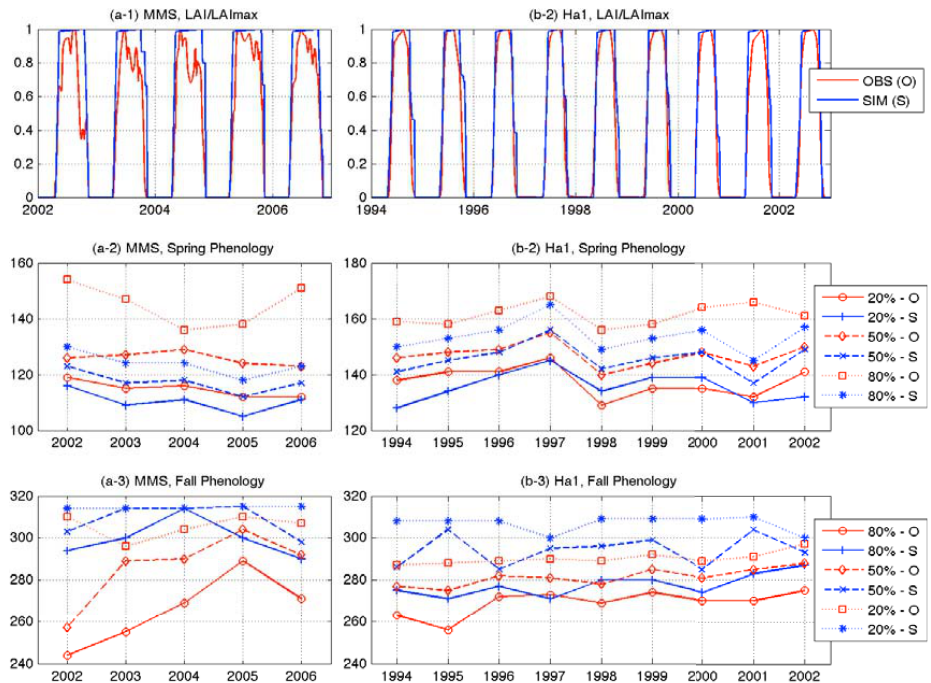
Figure 3. Daily simulated (S) and observed (O) phenology: (top) LAI/LAImax, (middle) phenological dates (day of year) for spring leaf-out at percentage of maximum, and (bottom) phenological dates (day of year) for fall senescence in MMS and Ha1. These results show good simulated timing of initial leaf-out and final senescence but lack of the gradual rate of these, such that the maximum leaf-out occurs too soon and the period of peak growth is too long. The gradual behavior could be simulated through a rate constraint.